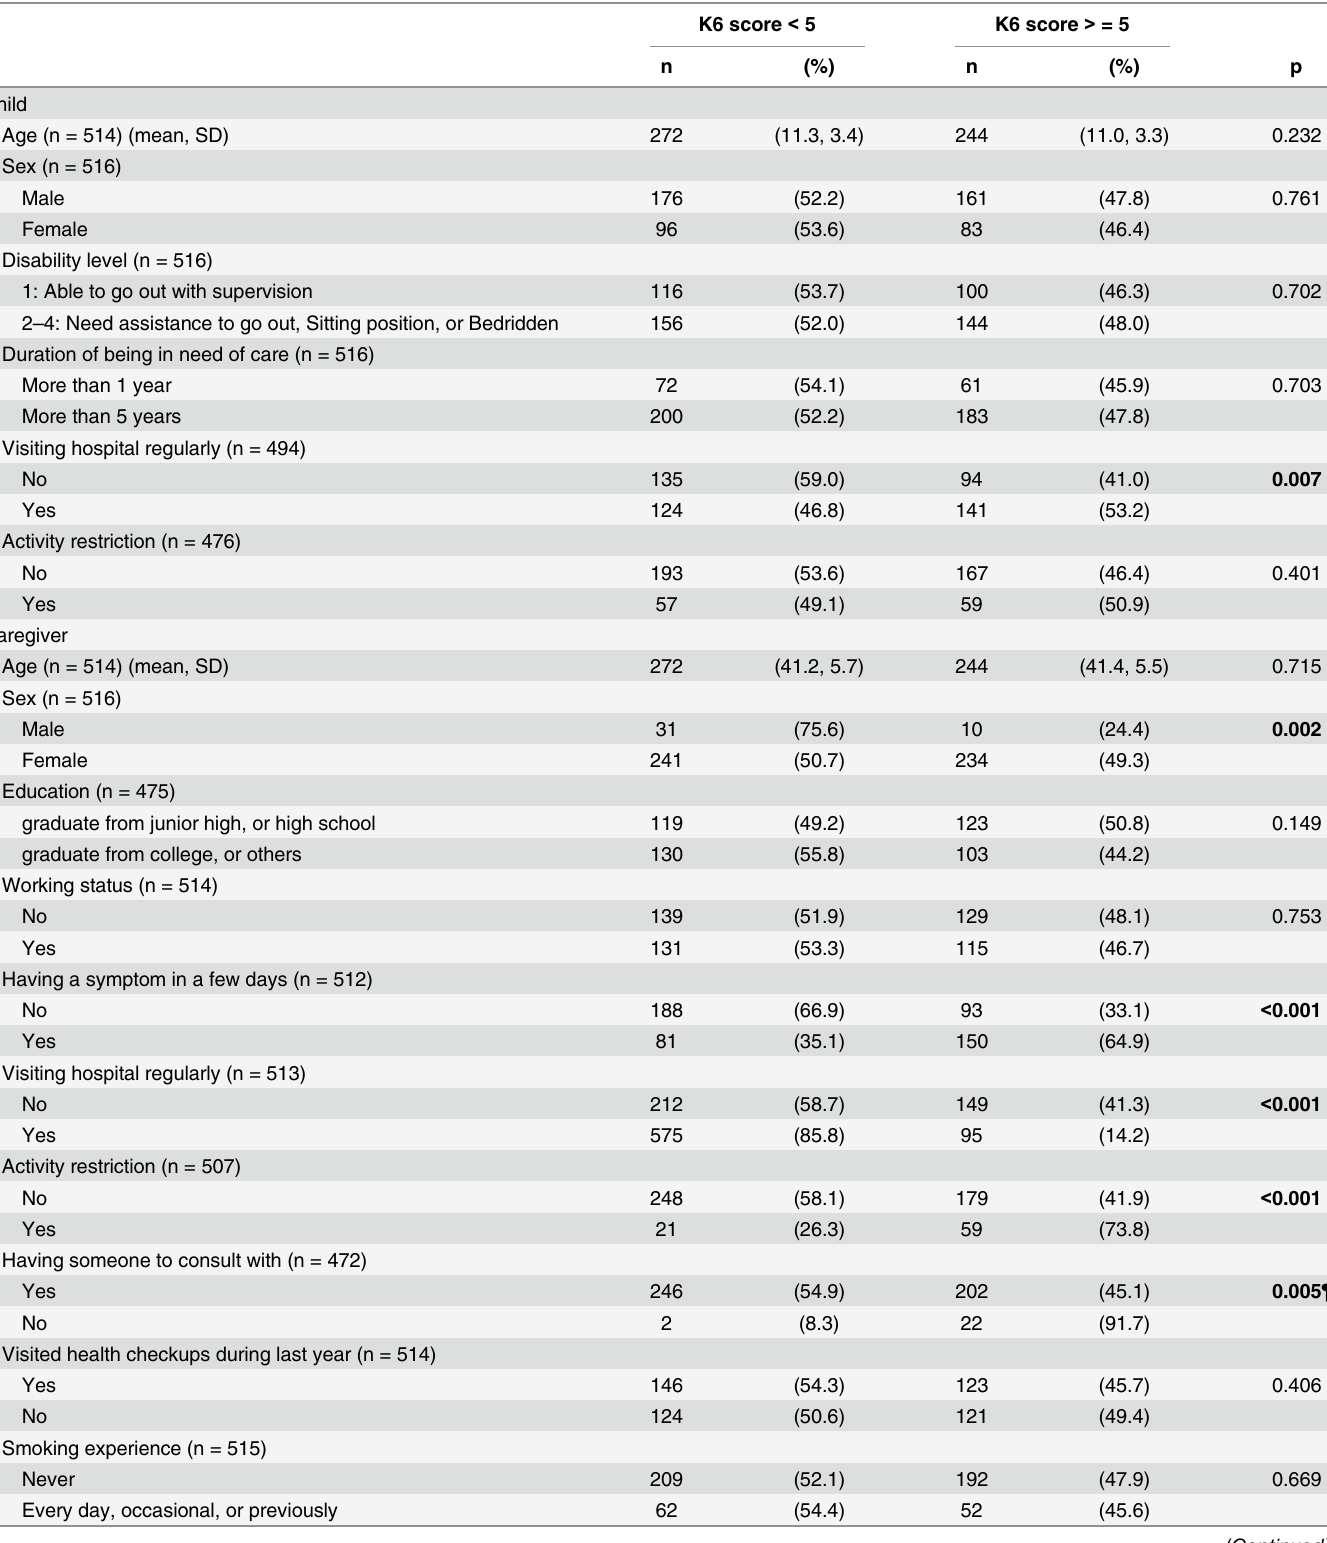
Table 2. Association caregiver ’ s mental health and characteristics of children, caregiver, and